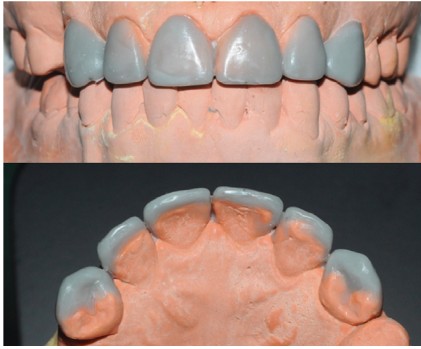
Figure 2: Diagnostic waxing proposed to reanatomize and provide harmony to the patient’s